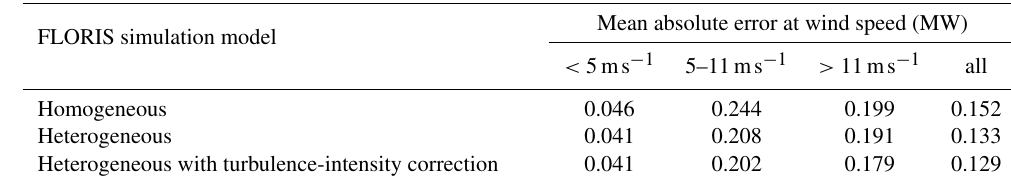
Table 3. Mean absolute error in individual turbine power output for all FLORIS models, tabulated for comparison within varying ranges of wind speeds. Total rated wind farm output was scaled to 100MW for